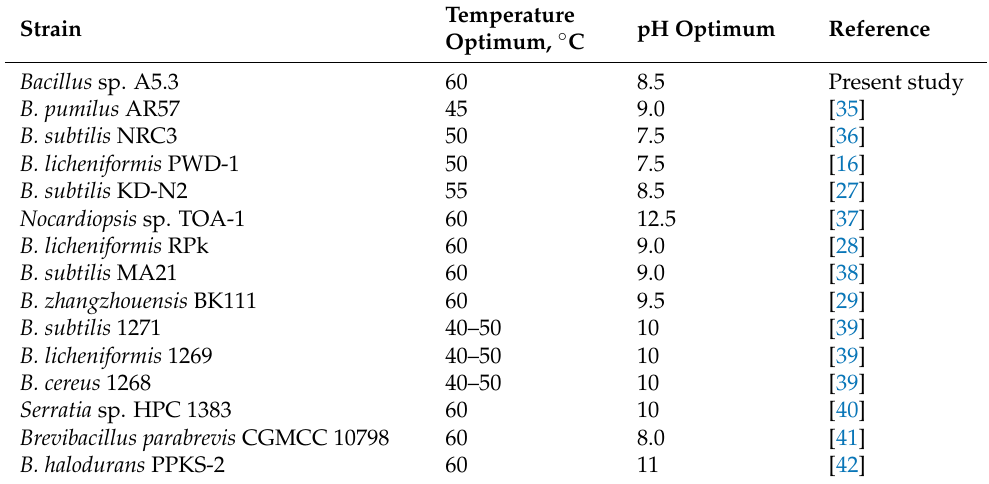
Table 2. Comparison of biochemical properties of various bacterial keratinases with properties of the enzymatic extract from Bacillus sp.